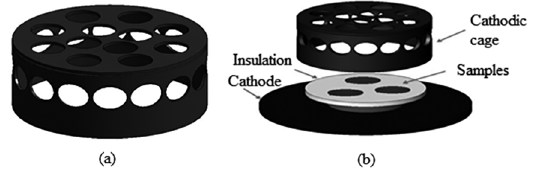
Figure 1. (a) Schematic representation of the cathodic cage (b) Arrangement of the samples in the cathodic cage. All plasma interactions occur in the cathodic cage and not directly in the samples, being the last ones mentioned are in floating potential, isolated by an alumina disk. The cage works as the negative pole, the cathode, and the reactor chamber as the positive pole, the